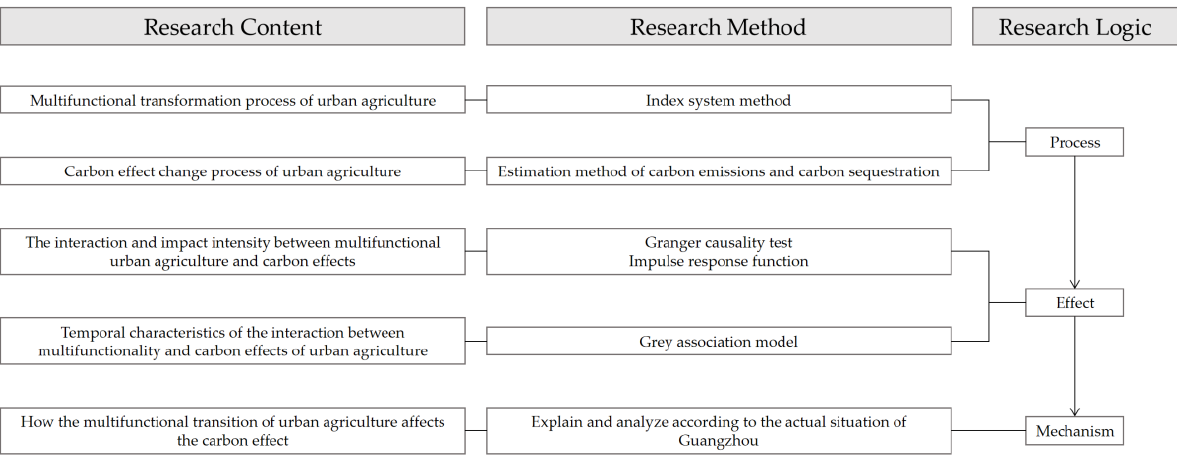
Figure 2. Study design.